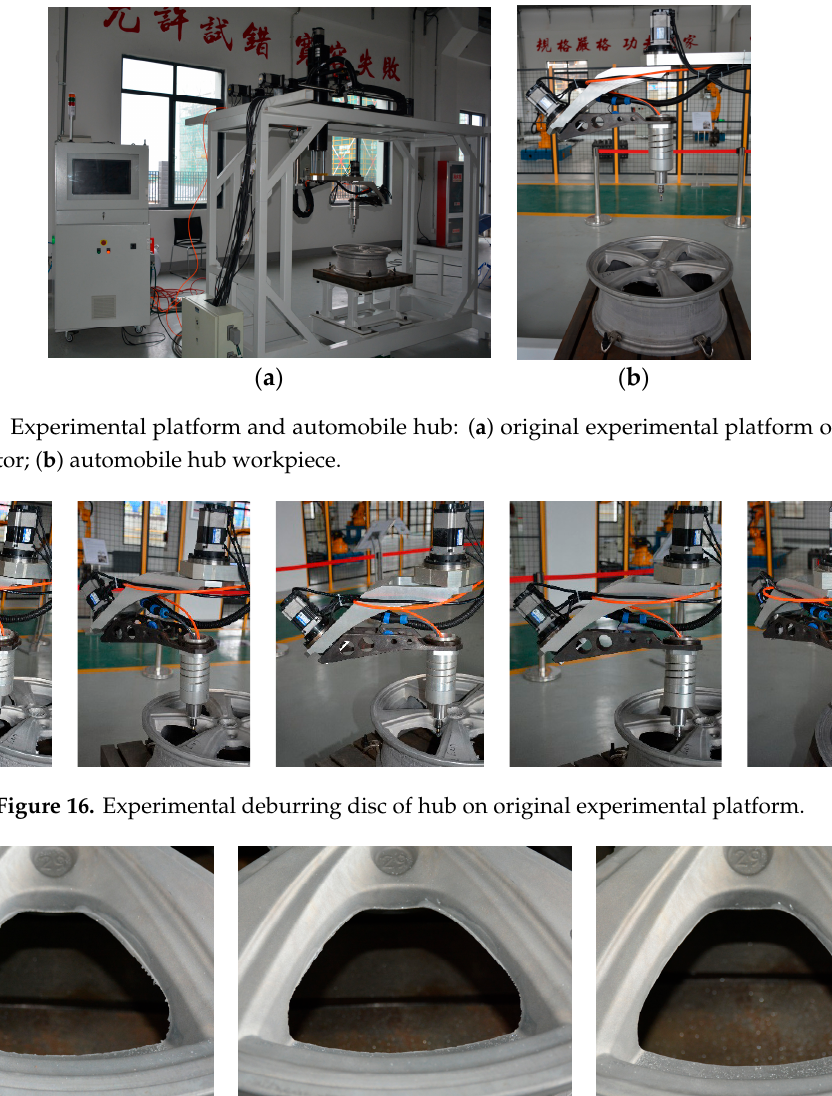
Figure 18. Results of target planning path and actual tool path of experimental deburring. Figure 19. Deviation results of target planning path and actual tool path of experimental deburring for disc of hub.